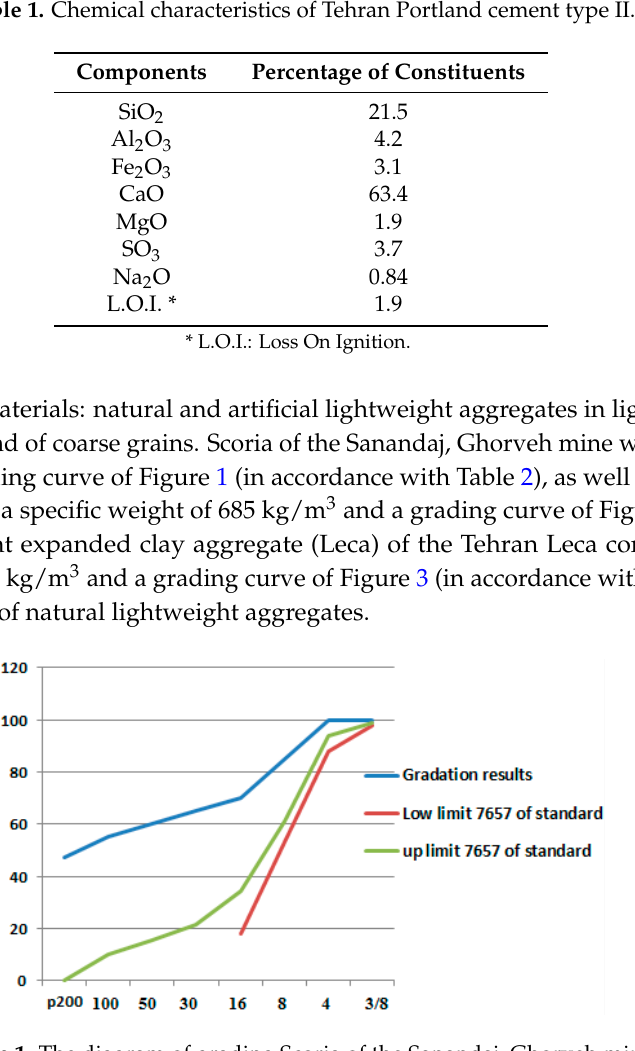
Figure 1. The diagram of grading Scoria of the Sanandaj, Ghorveh mine. Table 2. Grading test specifications of Scoria of the Sanandaj, Ghorveh mine.